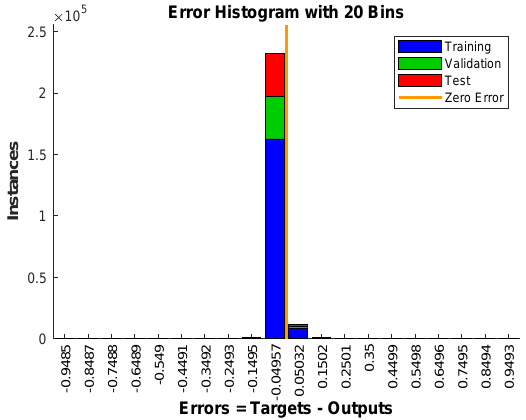
Figure 12. The neural network training states with gradient and validation fail statistics as a function of number of epochs.